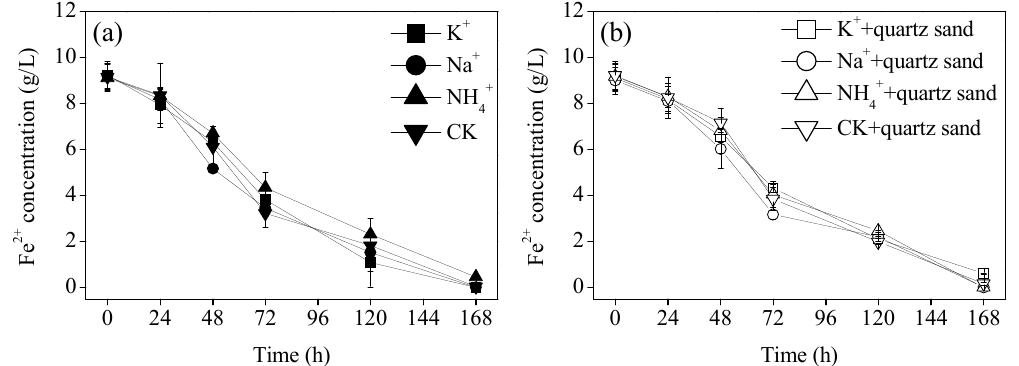
Figure 1. Change of Fe 2 + concentration ( a ) without and ( b ) with quartz sand in simulated acid mine drainage (AMD) system.